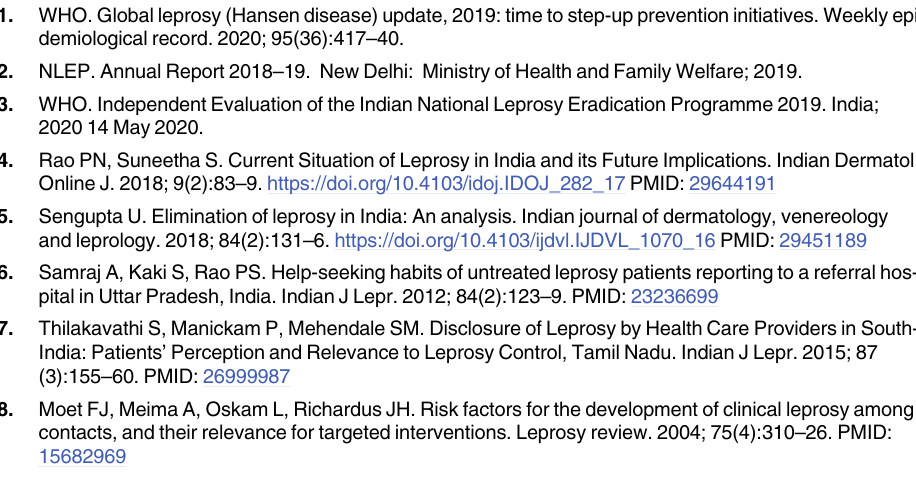
S1 Table. Number of cases detected through LCDC campaign and their timings.